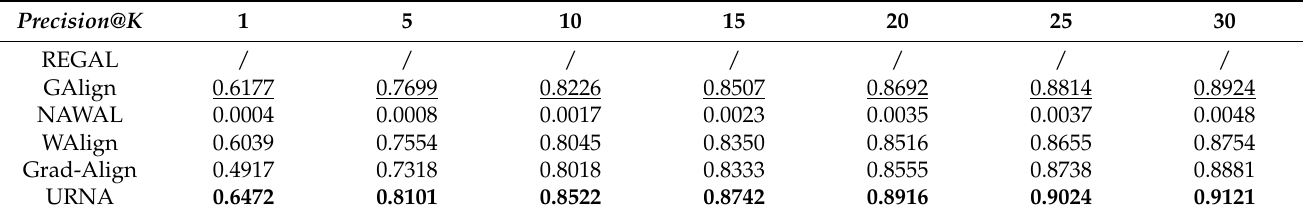
Table 4. Experimental results on allmv/imdb given different Precision @ K settings. Here, the best and second best performers are highlighted by bold and underline,